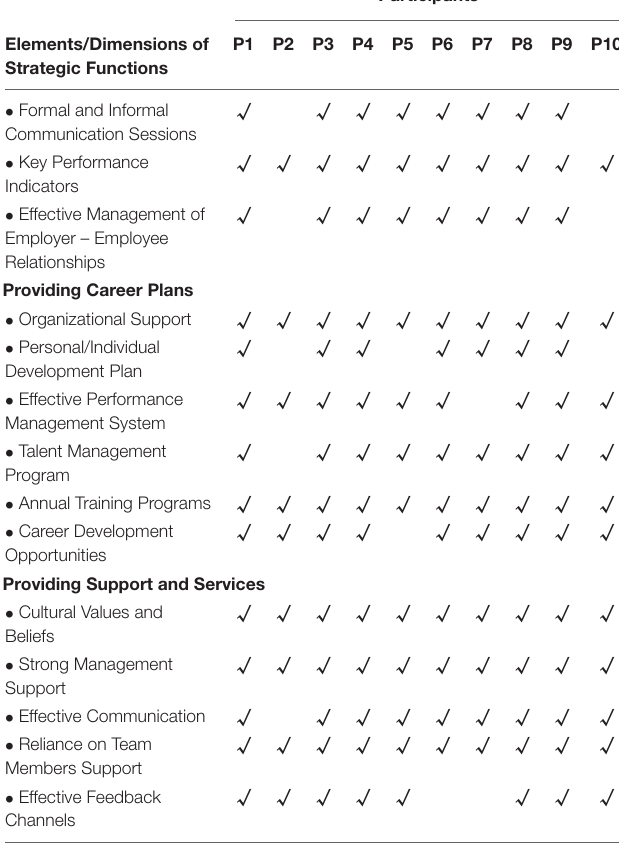
TABLE 3 | Elements/dimensions and strategic functions for human resources professionals’